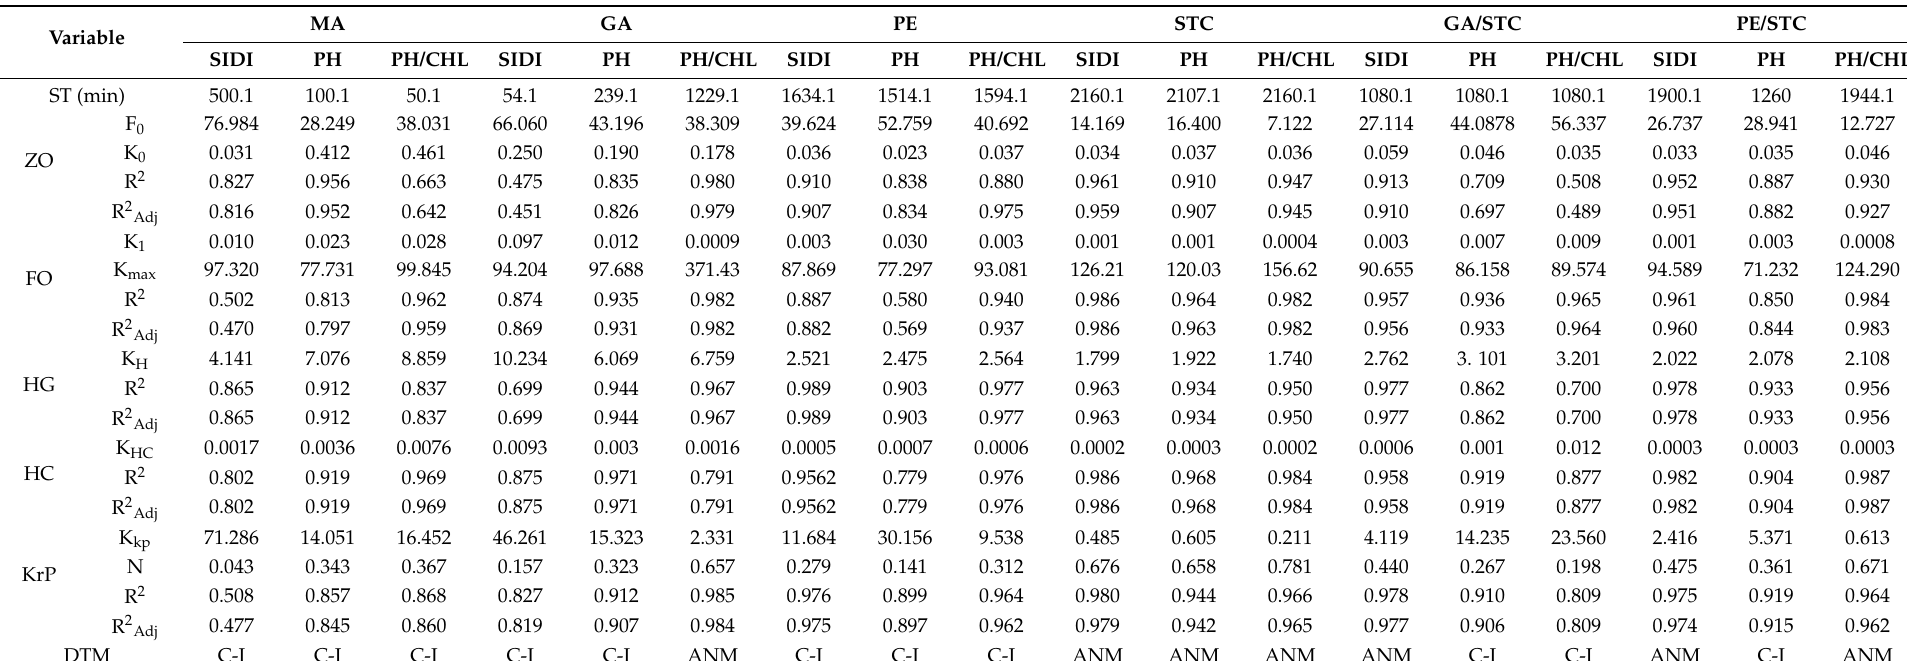
Table 6. In vitro release assays at pH